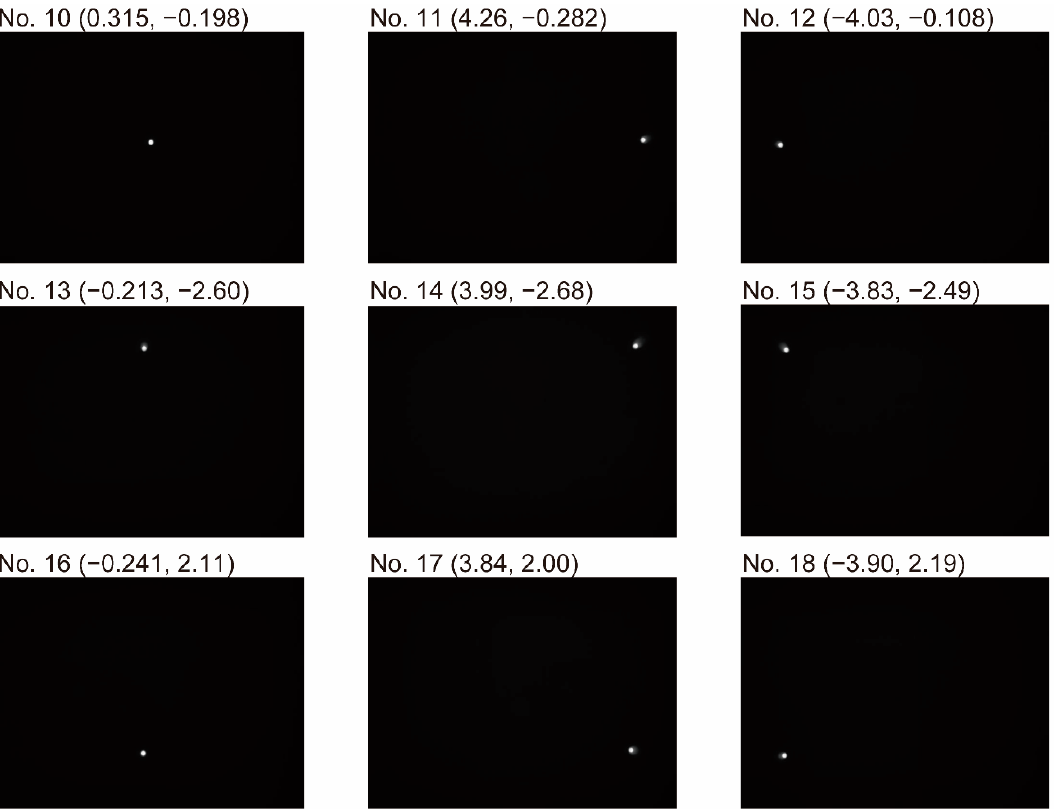
Figure A3. Captured thermal images of the light source at 1 m from the hybrid lens. Sensors 2020 , 20 , x FOR PEER REVIEW